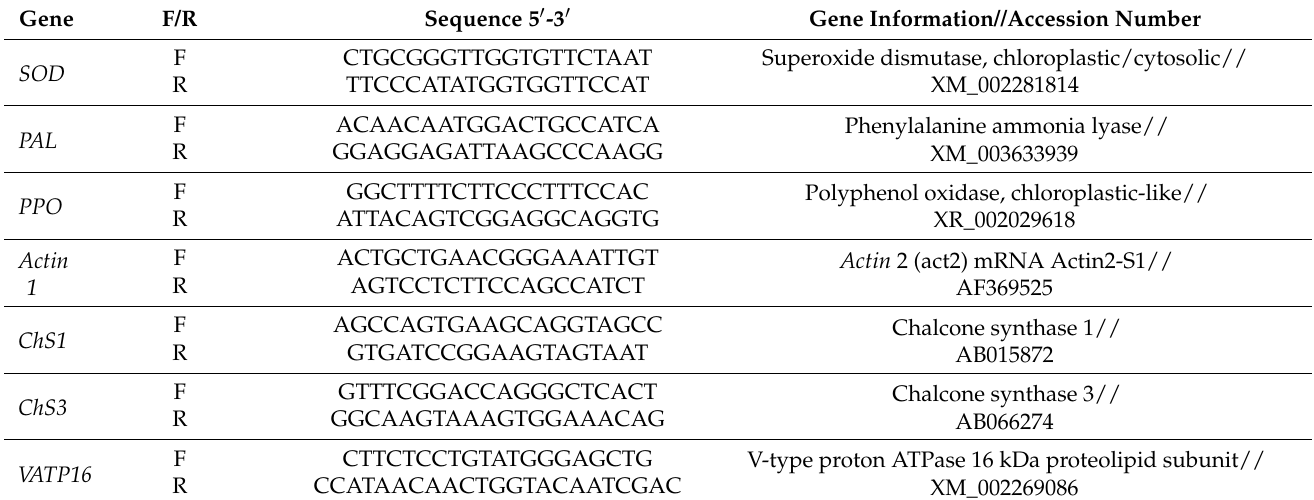
Table 2. Sequences of the primers used for evaluation of expression